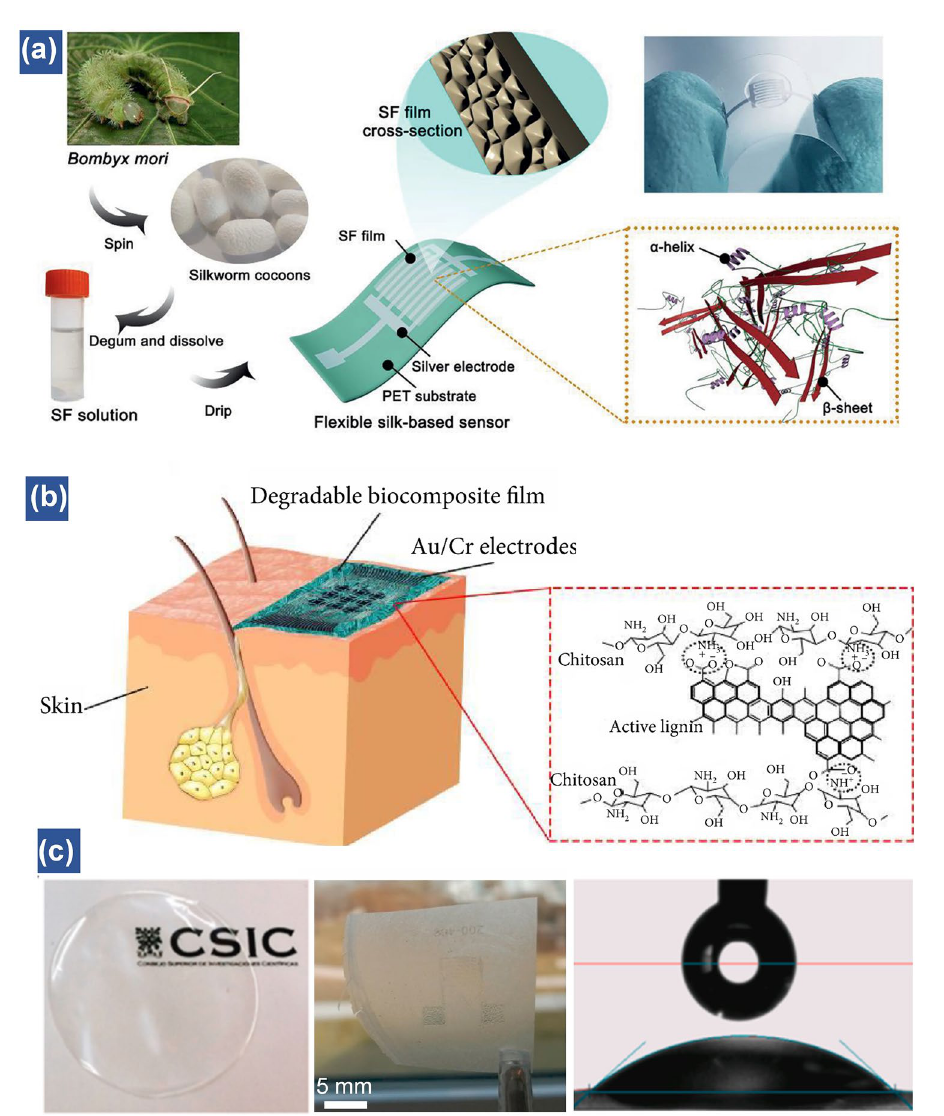
Fig. 5 Natural polymers-based flexible humidity sensors. ( a ) Schematic illustration showing the fabrication of the SF-based humidity sensor. Insets illustrate cross-section and structure of the natural SF film used to fabricate the sensor [126]. Copyright 2020 Wiley. ( b ) Schematics of a biodegradable and biocompatible humidity sensor attached on the skin. The inset shows the chemical structure of natural functionalized polysac- charide film used to fabricate the sensor [54]. Copyright 2020 Science Partner Journal. ( c ) Optical photographs and water contact angle of